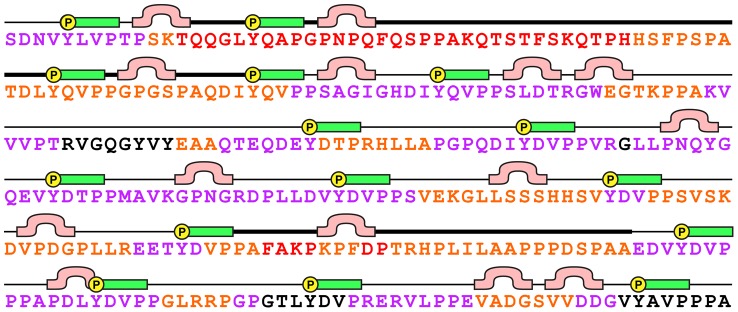
Consensus of predictions of CasSD disorderliness using multiple prediction programs.YxxP motif is represented by a green bar with a circled P representing the tyrosine residue to be phosphorylated. Residues predicted to be disordered by less than half of the programs are in black, and those predicted by progressively more programs are colored in purple, orange, and red. Lastly, a segment predicted by NetTurn P1.0 to assume a β-turn is shown by a pink Ω-shaped bar. See the Materials and Methods for details.